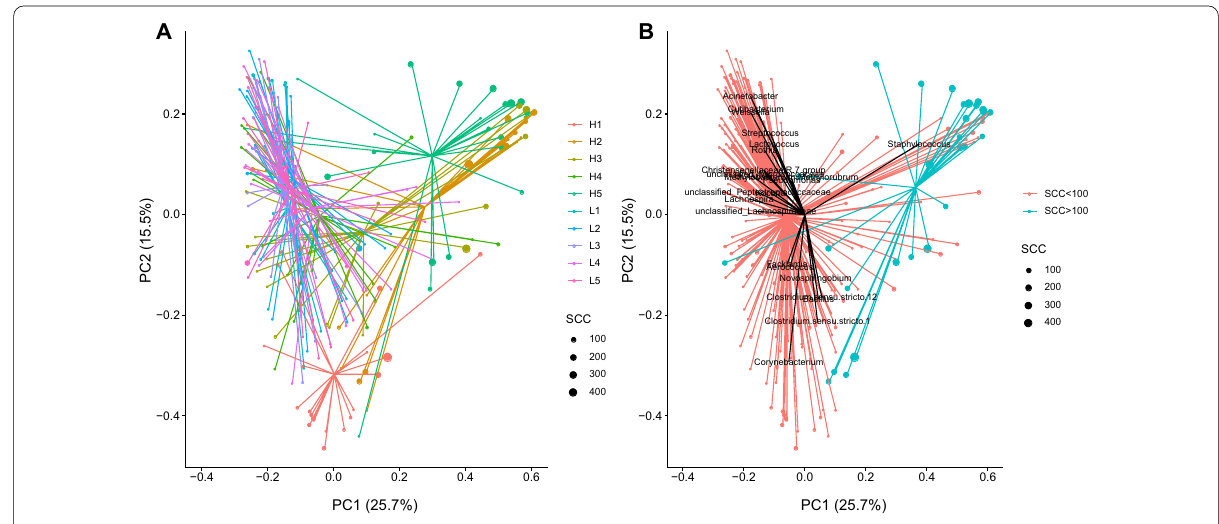
Fig. 2 PCoA of the udder milk samples obtained from 10 cows over 5 months of sampling and grouped by A cow ID, and B SCC during sampling. Size of the points indicate the level of